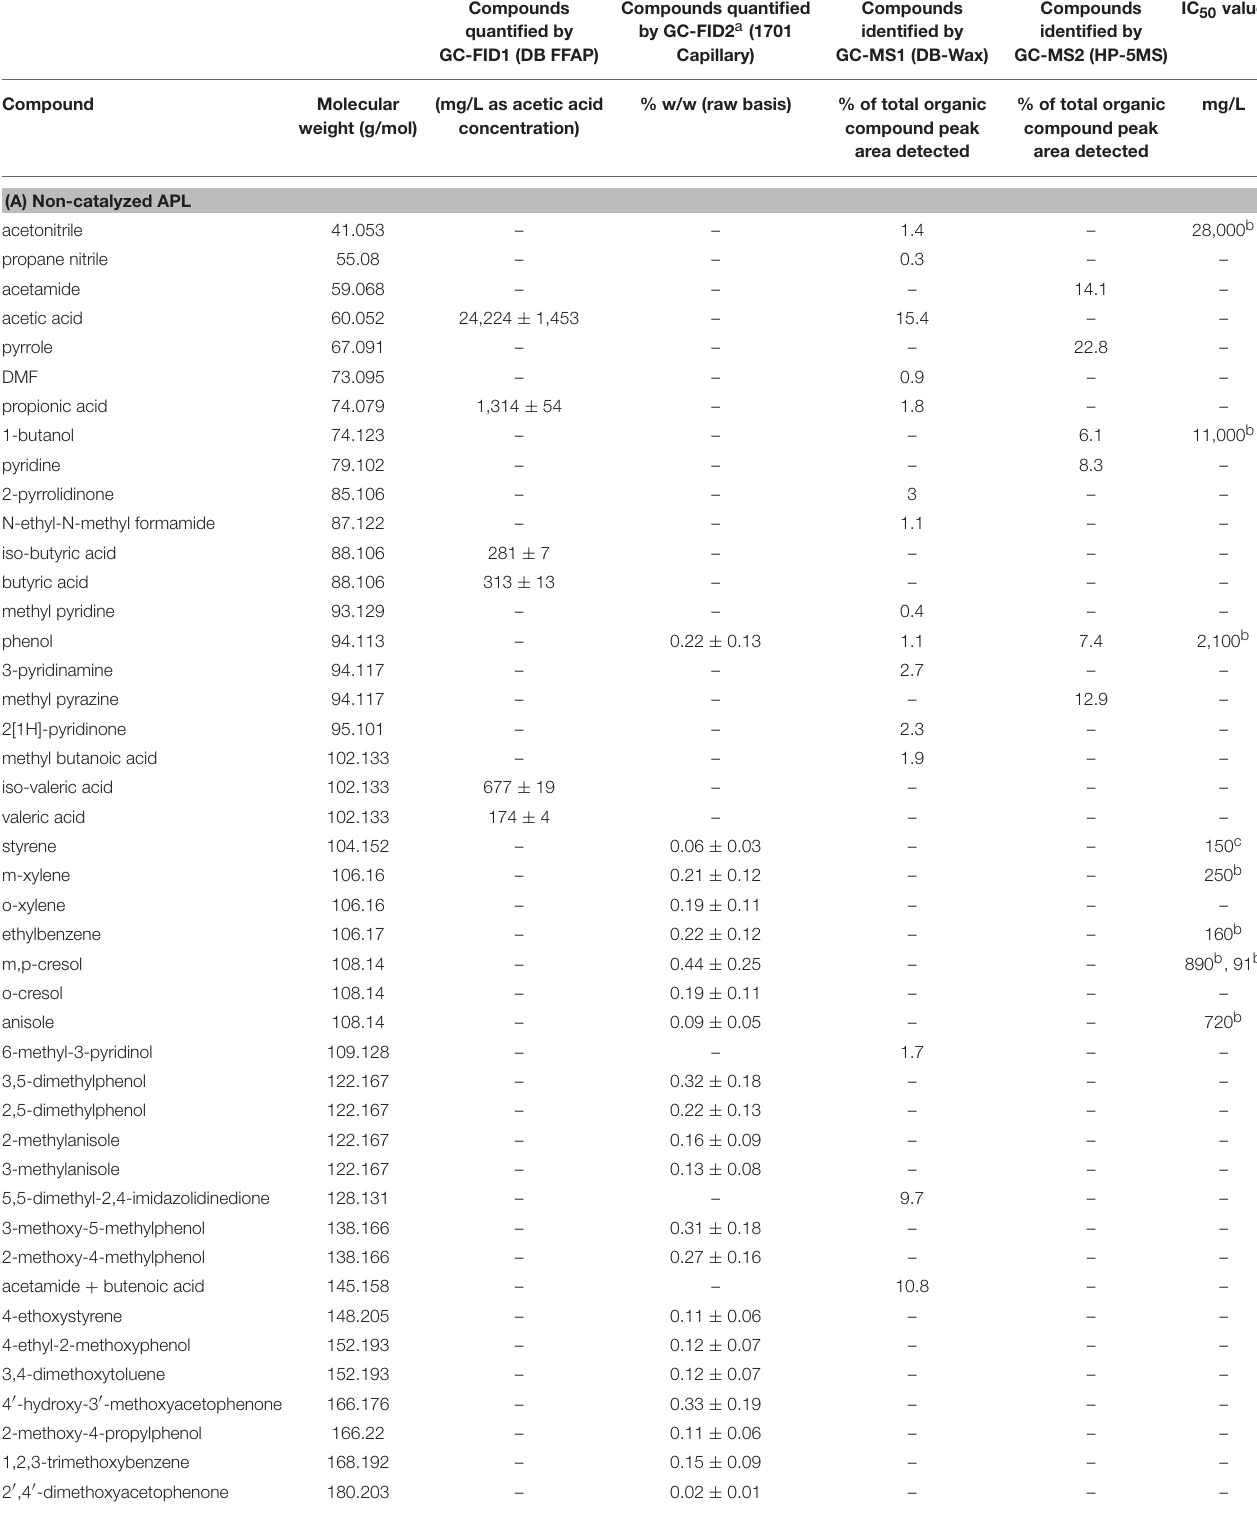
TABLE 3 | APL organic constituents identified by GC-MS and GC-FID